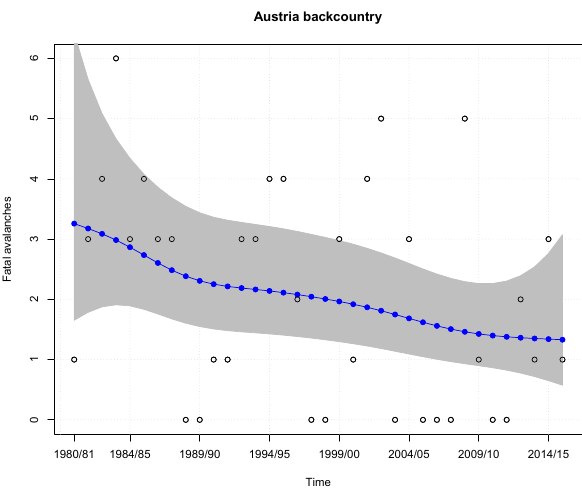
) annual backcountry •